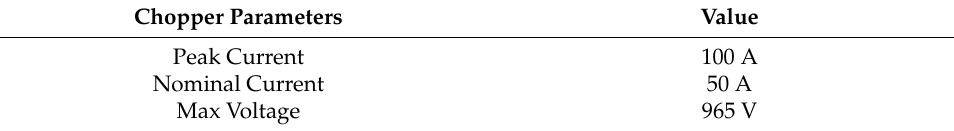
Table 6. Parameters of the selected braking